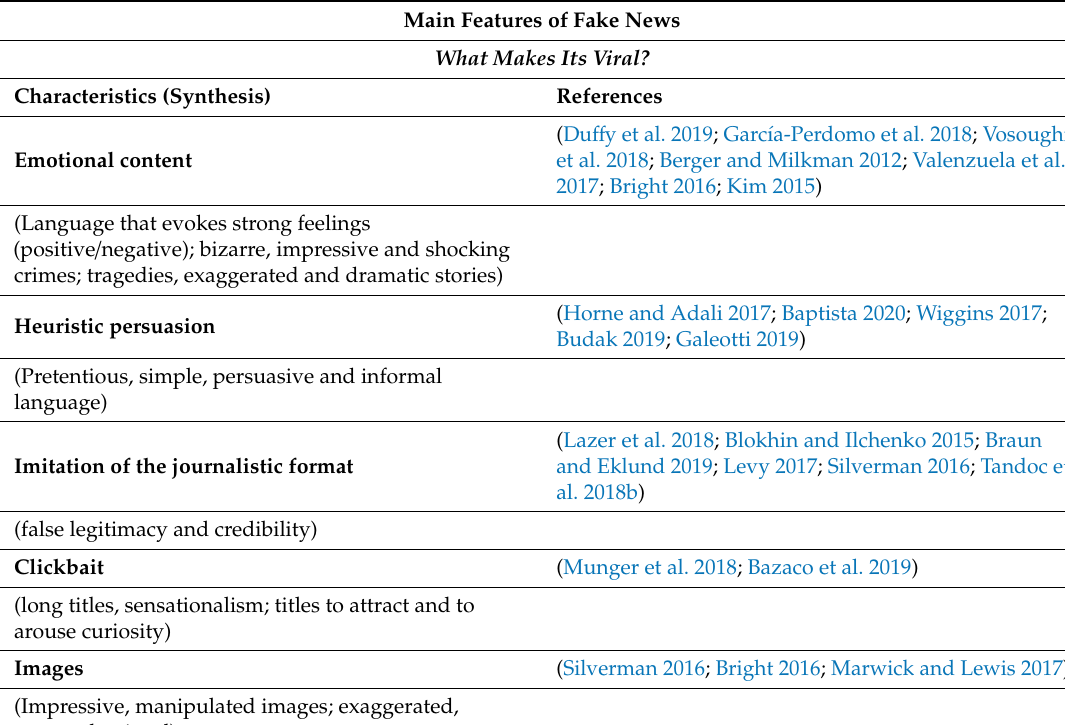
Table 1. Main features of fake